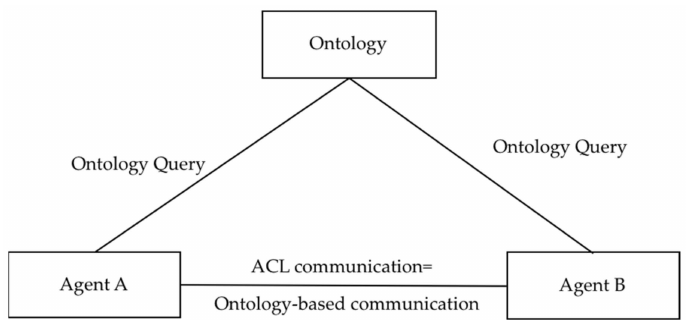
Figure 8. The illustration of the ontology-based agent communication model